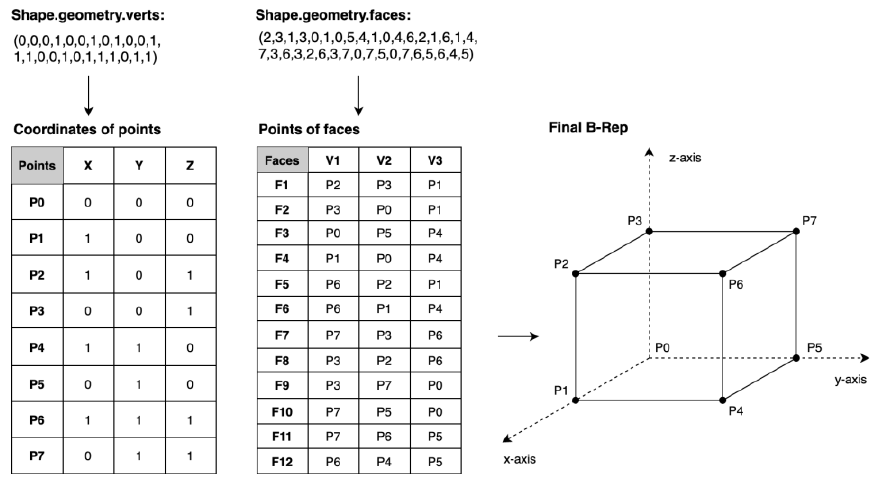
Figure 5. Converting triangulation elements into geometric shape.